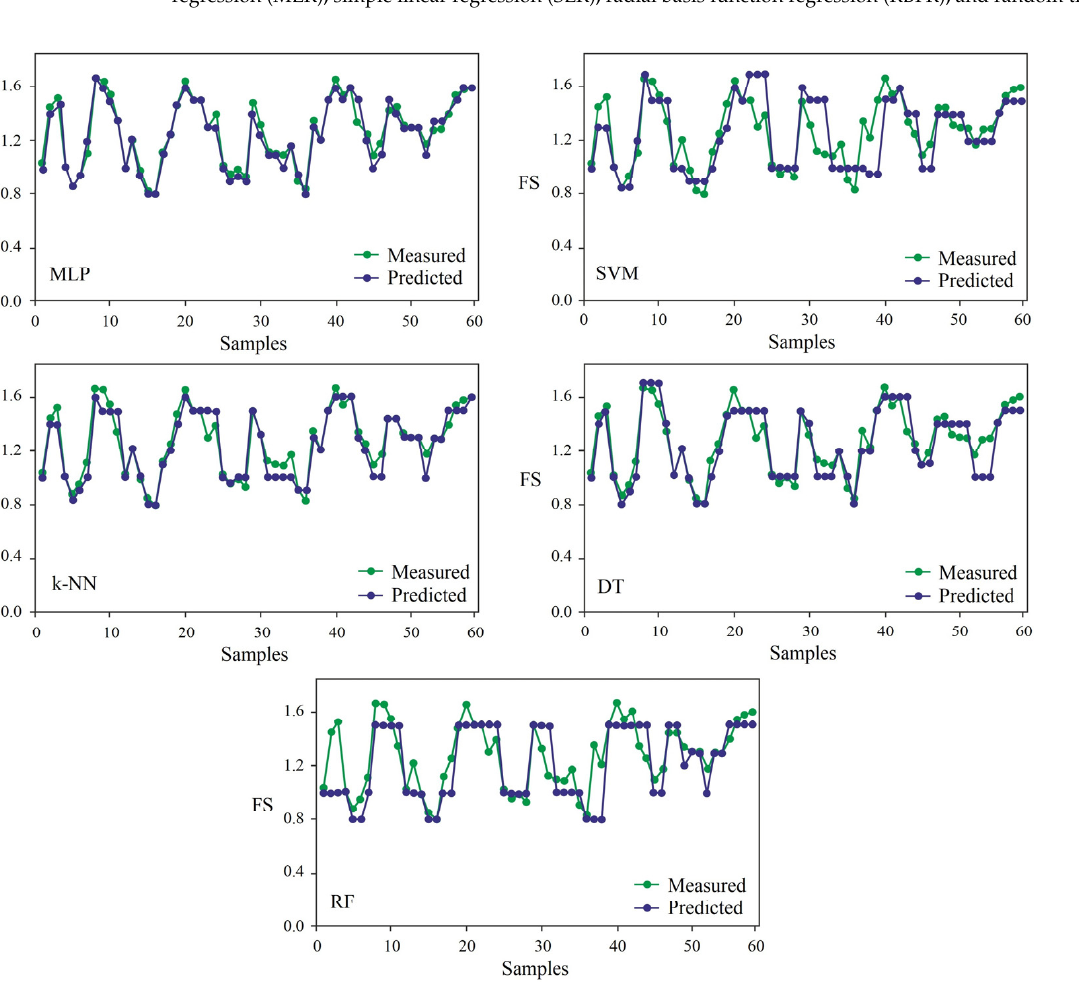
Figure 3. Results of the FS prediction in the training set by machine learning-based models.